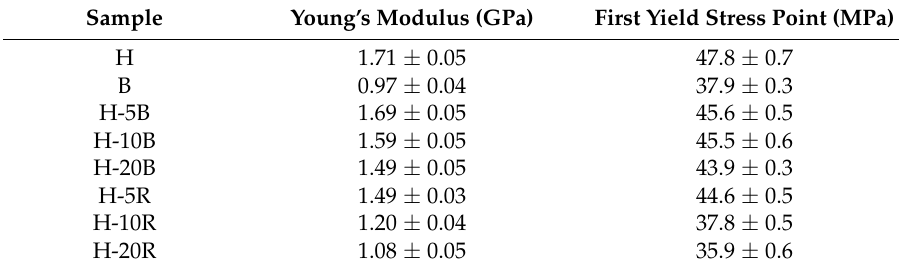
Table 6. Results of tensile test along MD (extrusion machine direction) for precursor films of PP homopolymer and blends with the random and block copolymers.